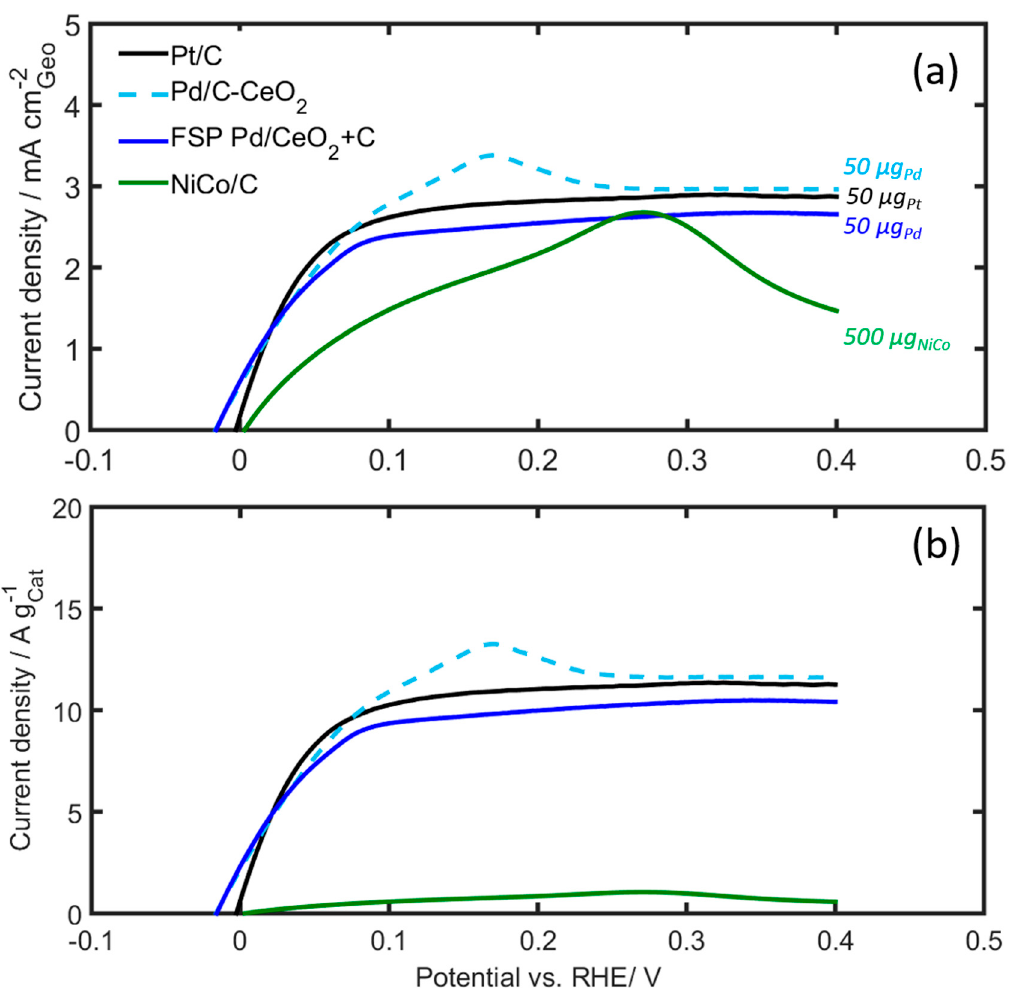
Figure 7. RDE voltammograms of Pd / C-CeO 2 , Pd / CeO 2 + C and NiCo / C compared to Pt / C in H 2 -saturated 0.1 M KOH. ( a ) Geometric current density, and ( b ) mass specific current density. Scan rate: 5 mV / s, rotating speed: 1600 rpm. The catalyst loading was 500 µ g based on NiCo, and 50 µ g for the PGM catalysts.